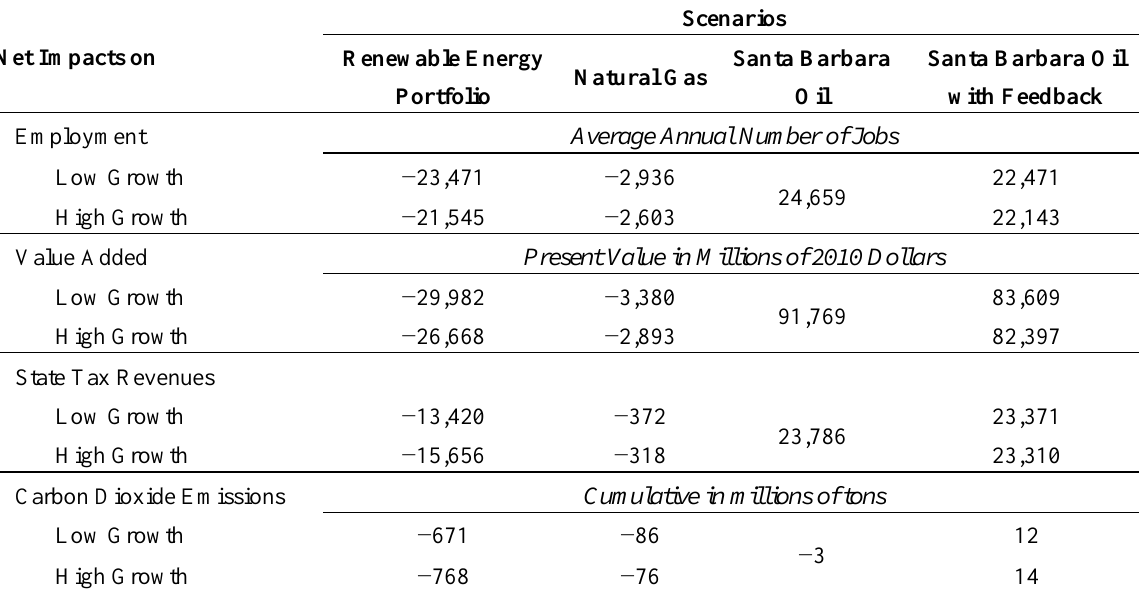
Table 5. Summary of economic and environmental